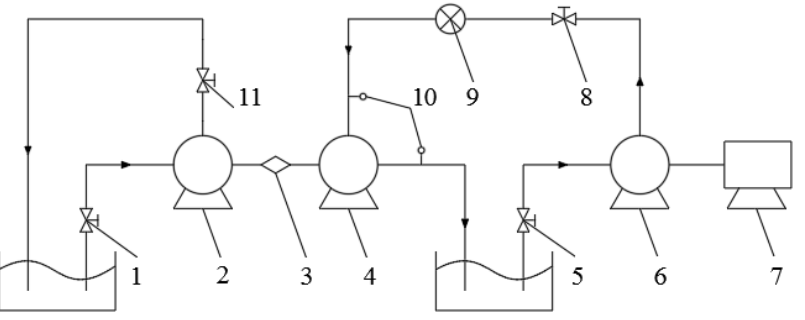
Figure 5. Experiment schematic diagram of PAT. 1, 5. Gate valve; 2. Consume pump; 3. Torque meter; 4. PAT; 6. Feed pump; 7. Motor; 8, 11. Control valve; 9. Flow meter; 10. Pressure transmitter.